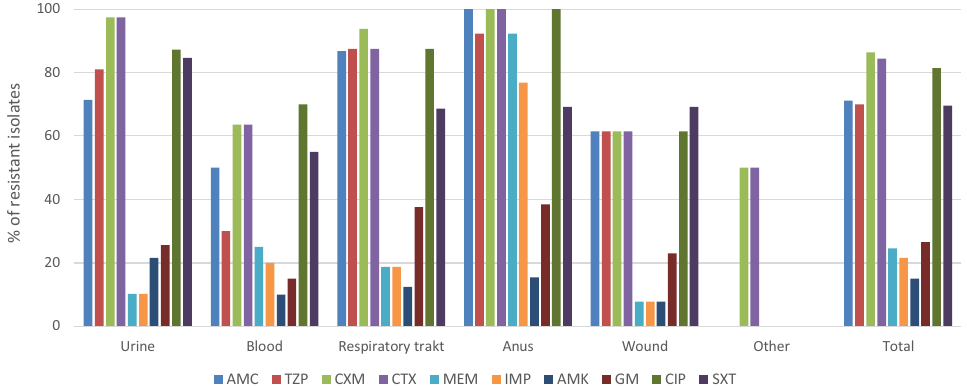
Figure 1. Antimicrobial resistance of K. pneumoniae isolates from different clinical materials. AMC— amoxicillin plus clavulanic acid, TZP—piperacillin plus tazobactam, CXM—cefuroxime,